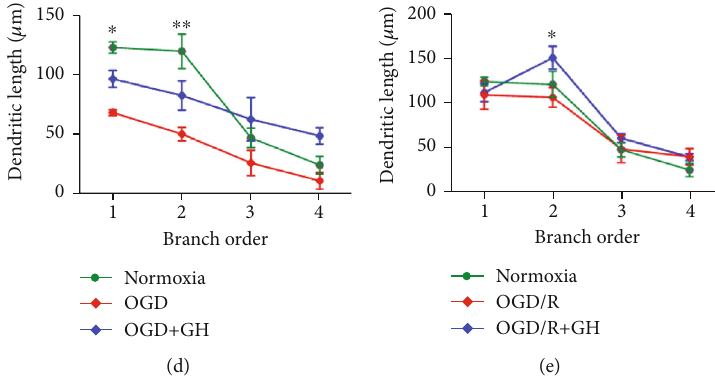
Figure 7: Growth hormone (GH) increases the number of neurites and dendritic length after OGD and reoxygenation (OGD/R) conditions. (a) Representative microphotographs of hippocampal cultures in each experimental group are shown. (a – f) Neurons stained with β -III- tubulin in: (i) normoxia, (ii) OGD, (iii) OGD/R, (iv) normoxia + GH, (v) OGD + GH, and (vi) OGD/R + GH. Scale bar: 50 μ m. (vii-xii) Schematic drawings from neurons stained with β -III-tubulin used for morphometric analysis, in (vii) normoxia, (viii) OGD, (ix) OGD/R, (x) normoxia + GH, (xi) OGD + GH, and (xii) OGD/R + GH. (b) The number of neurites was evaluated in 10 individual neurons for each group. (c) For dendritic length analysis, individual neurons were selected and drawn using the Simple Neuro Tracer software. Lower panels show the dendritic length by branch order analysis of hippocampal neurons exposed to (d) OGD and (e) OGD/R conditions. Bars represent mean ± SEM . Asterisks ( ∗ ) indicate signi fi cant di ff erences in comparison to control ( ∗ p < 0 : 05 ; ∗∗ p < 0 : 01 ; ∗∗∗ p < 0 : 001 ), and number sign (#) shows di ff erences between experimental groups (# p < 0 : 05 ; ## p < 0 : 01 ) as assessed by two-way ANOVA and Tukey as posthoc test. An unpaired Student ’ s t -test was used to compare control versus GH in normoxia condition and control versus GH in OGD/R condition (panel b), and control versus GH in OGD/R condition (c), and the at sign (@) indicates signi fi cant di ff erences (@ p < 0 : 05 ; @@ p < 0 : 01